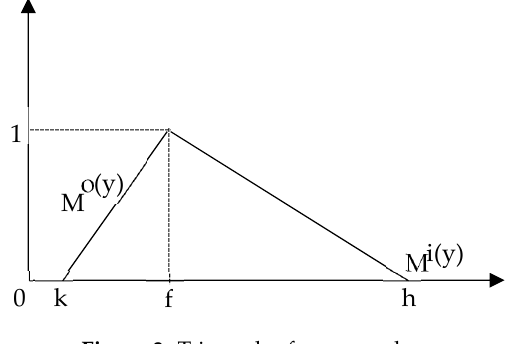
Figure 3. Triangular fuzzy number.